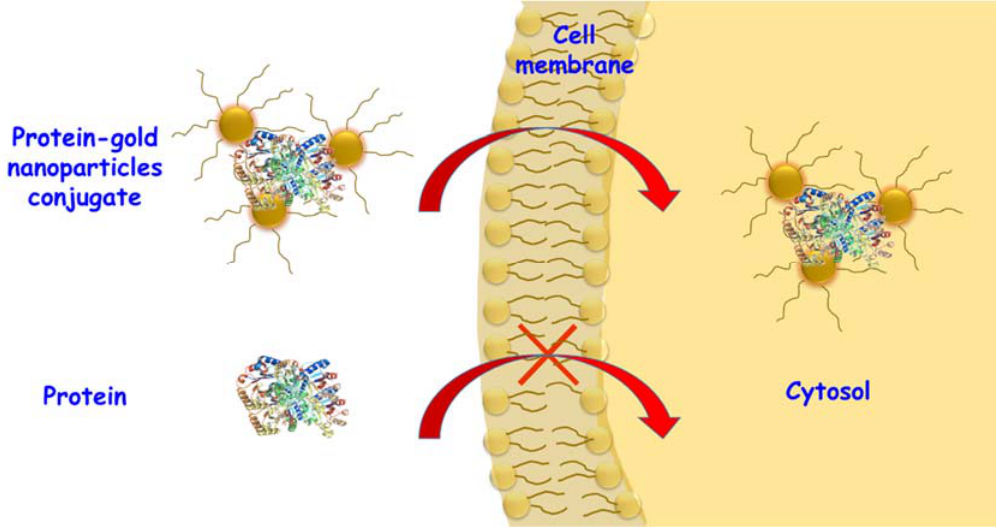
Figure 2. Scheme of protein adsorbed onto peptide coated gold nanoparticles to improve cell internalization by endocytic pathway.